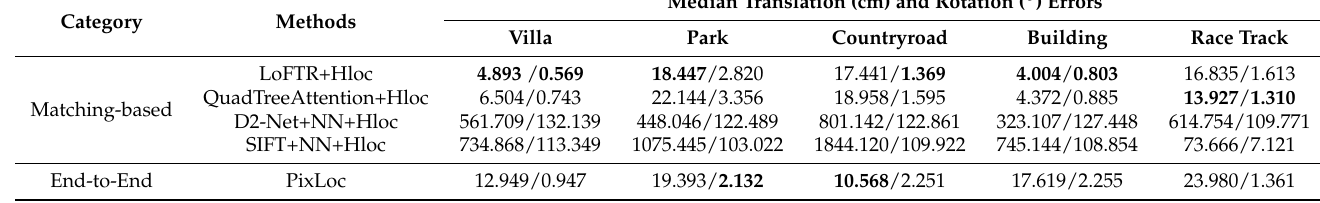
Table 7. We report the median translation (cm) and rotation ( ◦ ) errors. LoFTR achieves the smallest median translation error in three scenarios and the smallest median rotation in two scenarios. The best one is shown in bold